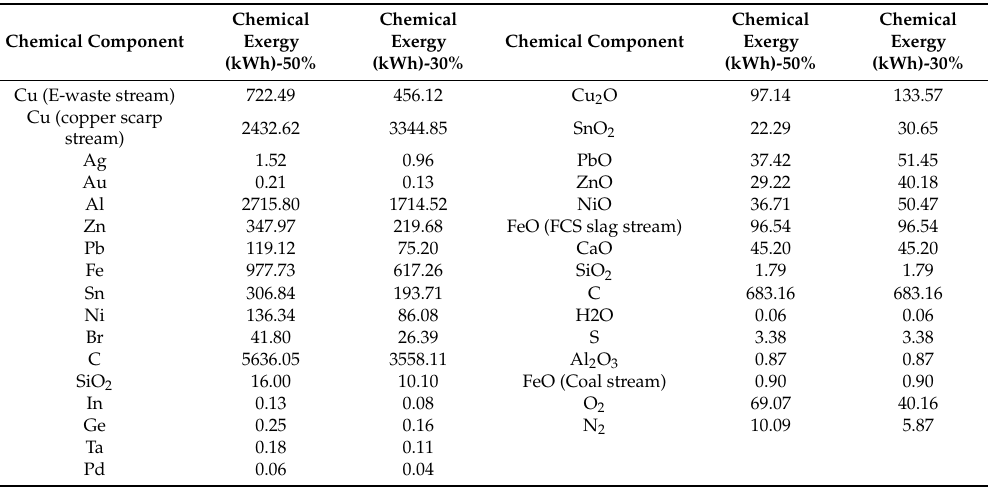
Table 5. Exergy values of materials injected into the reduction